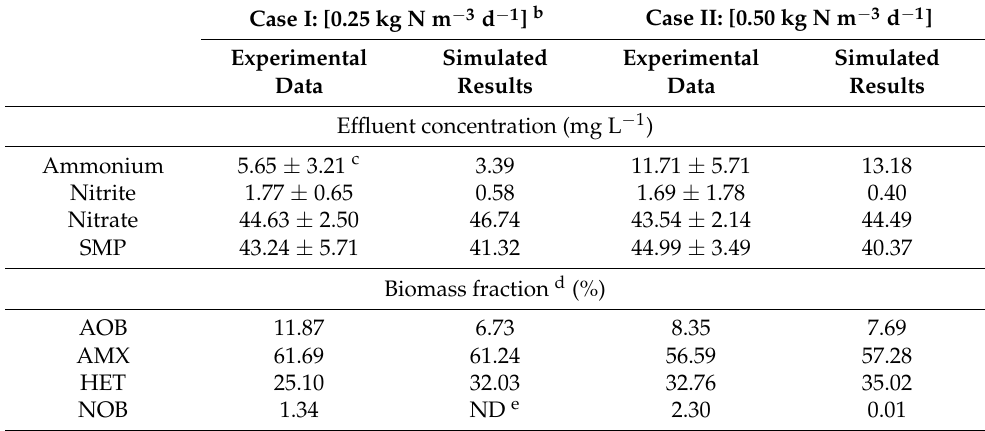
Table 1. Comparison simulated results with experimental data in the standard case a .